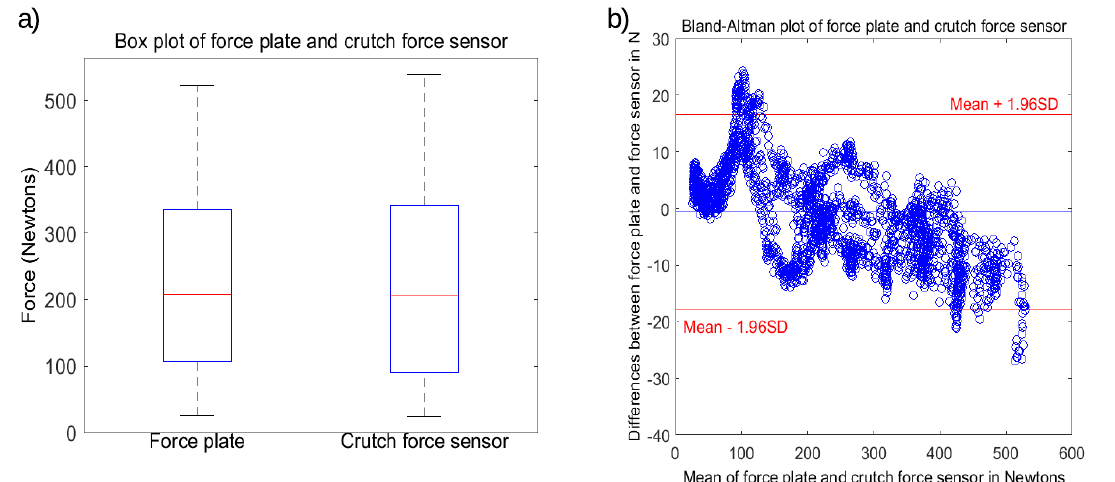
Figure 4. Results with data of the second recording after calibration. ( a ) Box plot. ( b ) Bland–Altman plot.